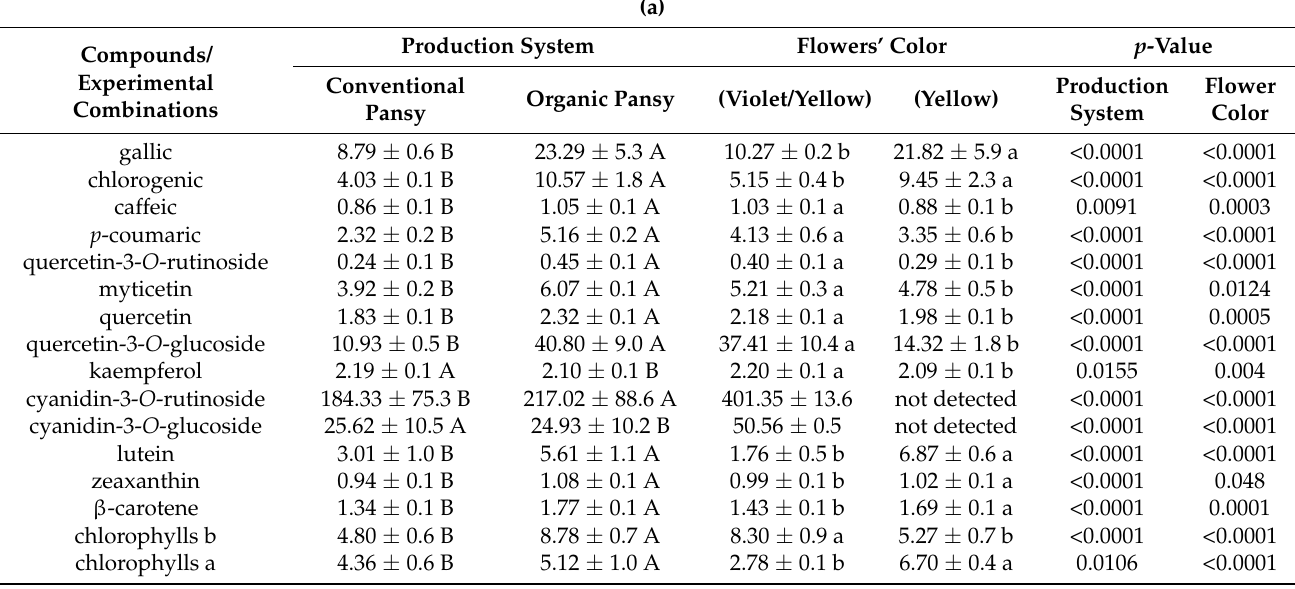
Table 2. ( a ) The mean values for the content of dry matter (in g/100 g F.W.) and other bioactive compounds (in mg/100 g F.W.) in pansy flowers with different flower colors and flowers from different production systems. ( b ) The interaction between experimental factors and the content of individual and identified bioactive compounds (in mg/100 g F.W.) in pansy flowers with different flower colors and from different production